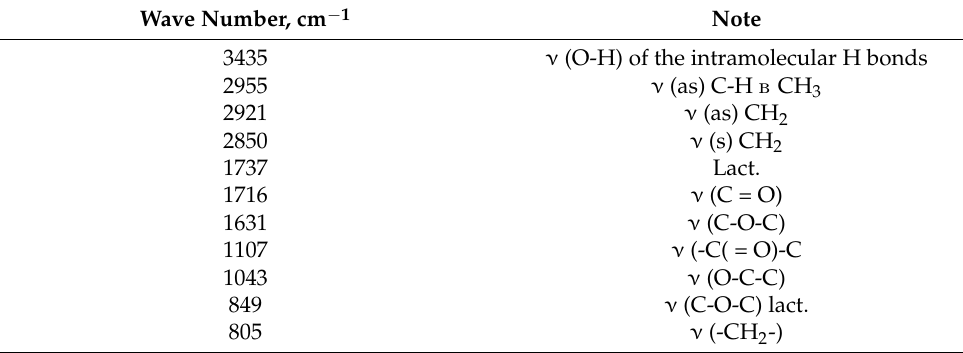
Table 6. IR characteristics of ginkgolide C.